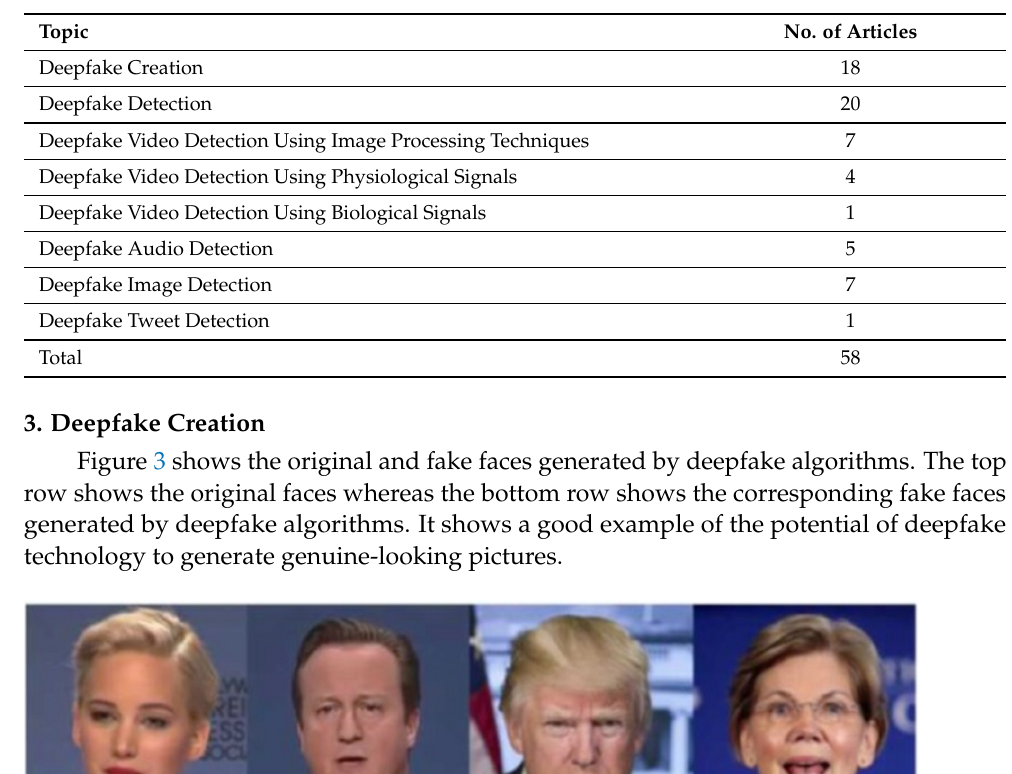
Table 2. Details of the selected articles with respect to sub-topics.